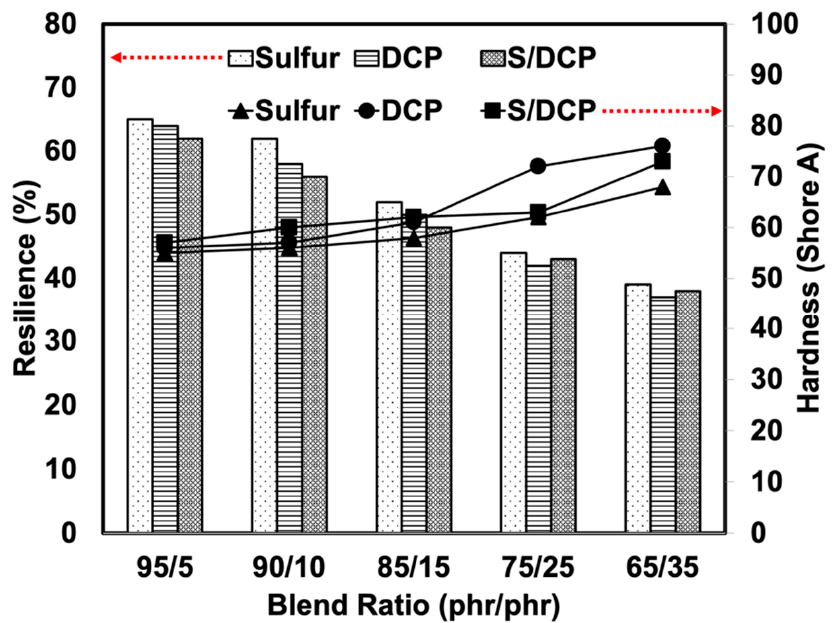
Figure 6. Hardness and resilience of NR/r-NBR blends prepared with various crosslinking systems.